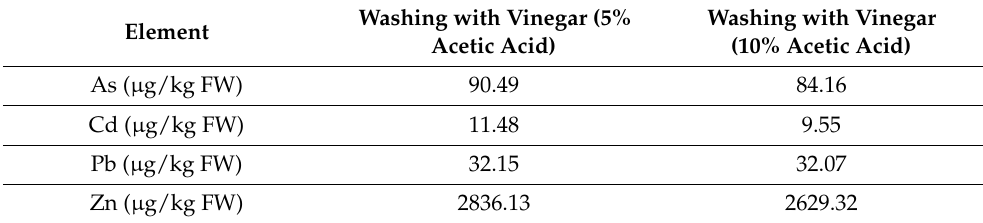
Table 6. The difference between the heavy metal concentrations in samples of fruit and vegetables washed with tap water and vinegar (5% and 10% acetic acid).